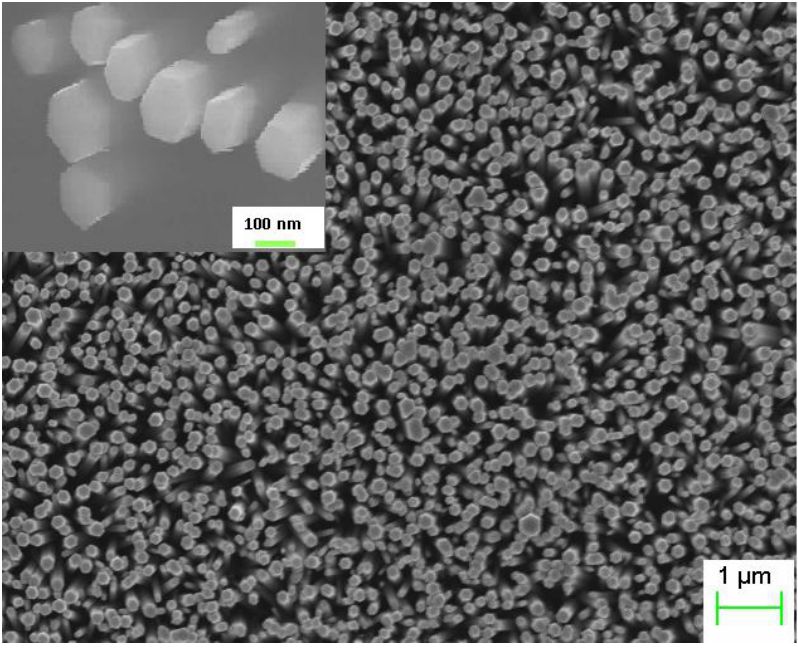
Figure 1. SEM image of the as grown ZnO nanorods (NRs) on Polyfluorene (PFO) polymer and the inset shows the SEM image after deposition of the spin on glass (SOG).